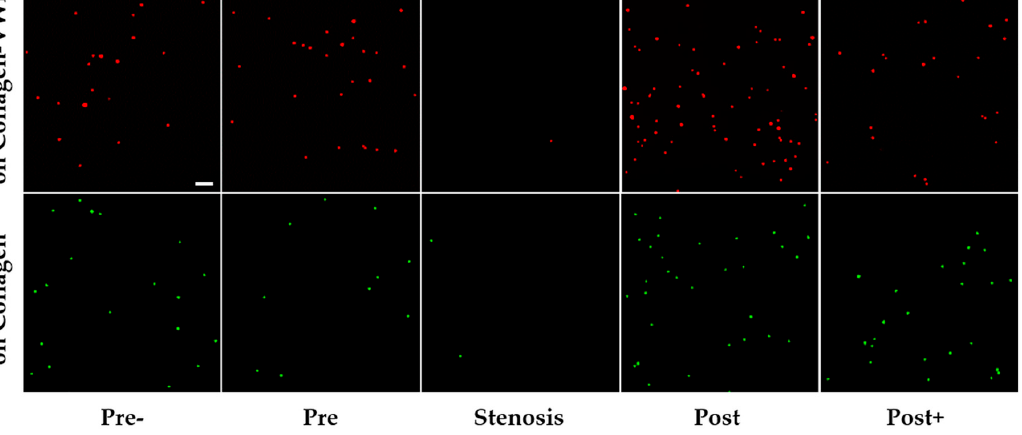
Figure 3. Confocal microscopy images of A1-NPs deposition at different spatial zones in the 75% stenosis model—collagen vs. collagen-VWF coated models. Scale: 1 µm.